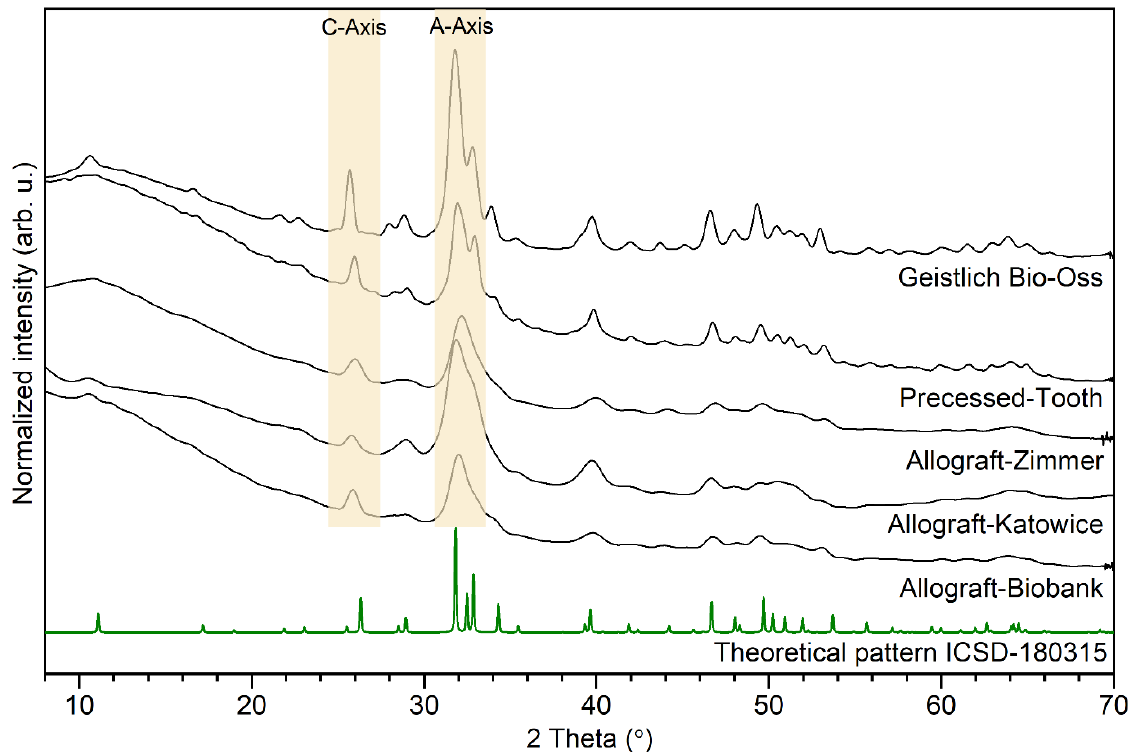
Figure 8. XRD patterns of investigated bone-reconstruction materials.